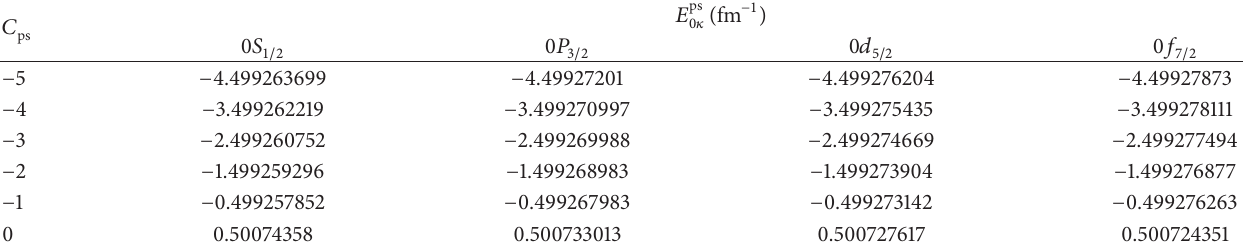
= −0.5 , 𝑎 = −0.02 , 𝑏 = 0.01 , and 𝑀 = 0.5 fm −1 ps ps ps